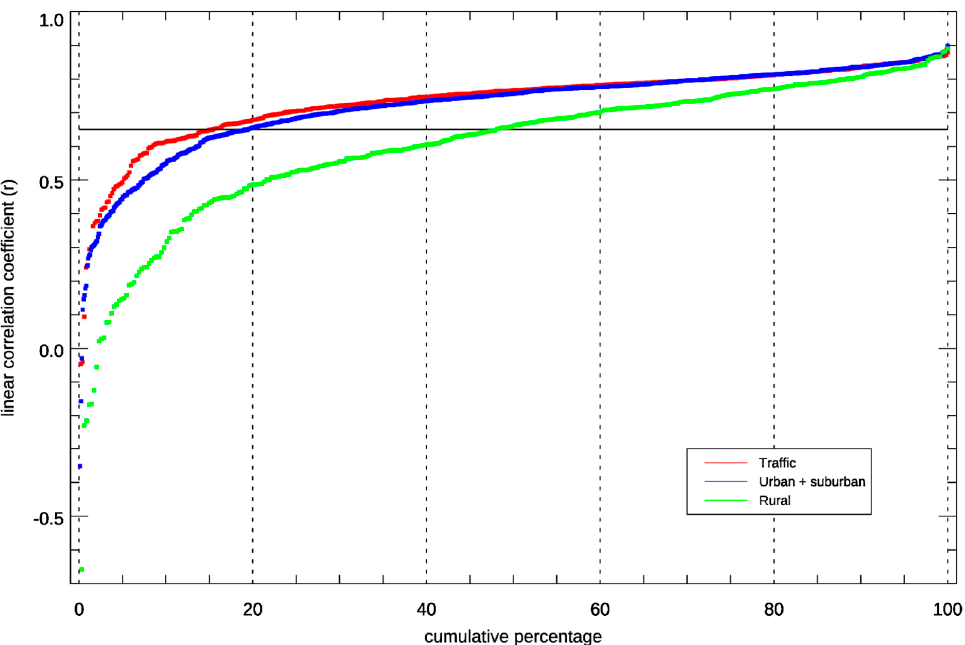
Figure 1. Distribution of r values for the generalised additive model (GAM) performance vs. observed daily mean concentrations at different station types for March–July 2015–2019. Stations with a value of r < 0.65 (threshold marked with a horizontal black line) were not used further in the analyses.